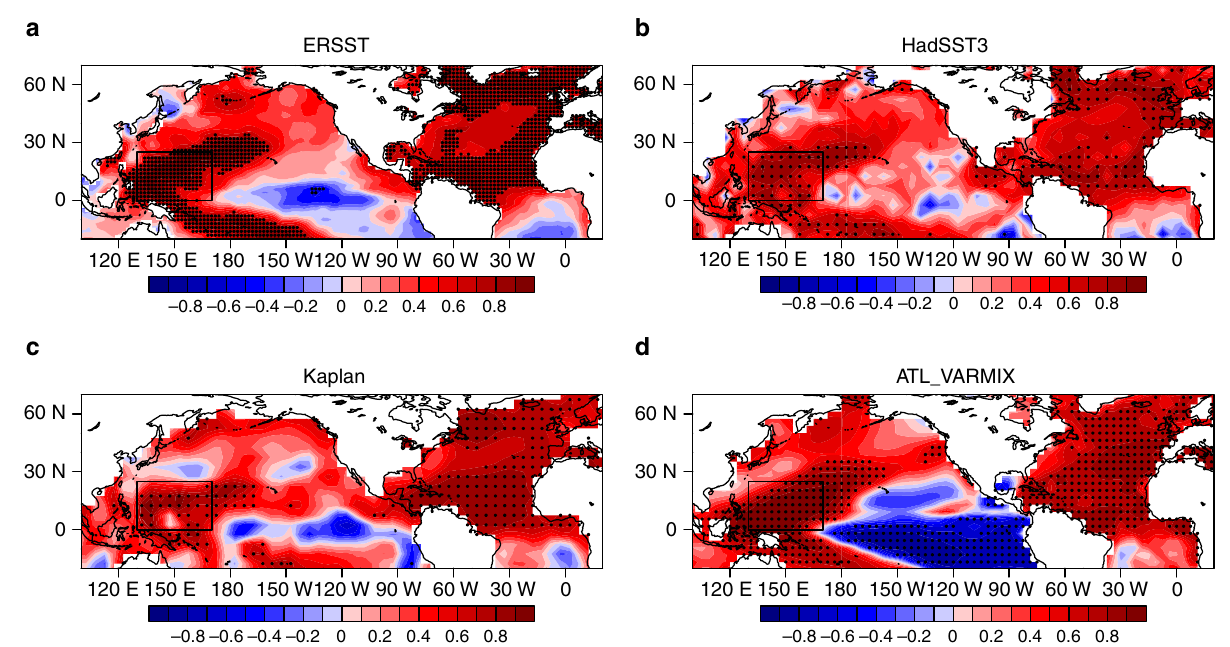
Figure 3 | Teleconnection between the Atlantic multidecadal oscillation and western tropical Pacific decadal variability. ( a ) Correlation map between the western tropical Pacific SST index and global SSTnorth of 20 (cid:2) S over decadal timescales for the period 1900–2013 in the ERSSTdata set. The black box indicates the region used to define the western tropical Pacific SST index (0 (cid:2) –25 (cid:2) N, 130 (cid:2) –170 (cid:2) E). ( b – d ) As in a , but based on the data from the HadSST3 data, Kaplan SSTdata and ATL_VARMIX simulations. In a – d , the long-term linear trends in SSTdata were removed prior to the correlation analysis, and dots indicate the correlations significant at the 95% confidence